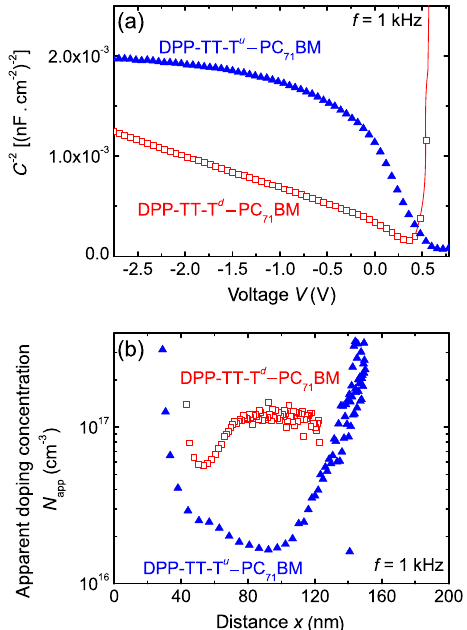
FIG. 2. (a) Mott-Schottky plot in the dark at 1 kHz for two thick devices of undoped DPP-TT-T u − PC 71 BM (solid triangles) and doped DPP-TT-T d − P 71 BM (open squares). The capacitance is inversely proportional to the space-charge-layer thickness that is controlled by the applied bias. Nevertheless, the space-charge layer is also governed by the doping level. (b) The gradient of the C − 2 function of V is inversely proportional to the apparent doping level N A . There are strong variations of the level of unintentional doping in our